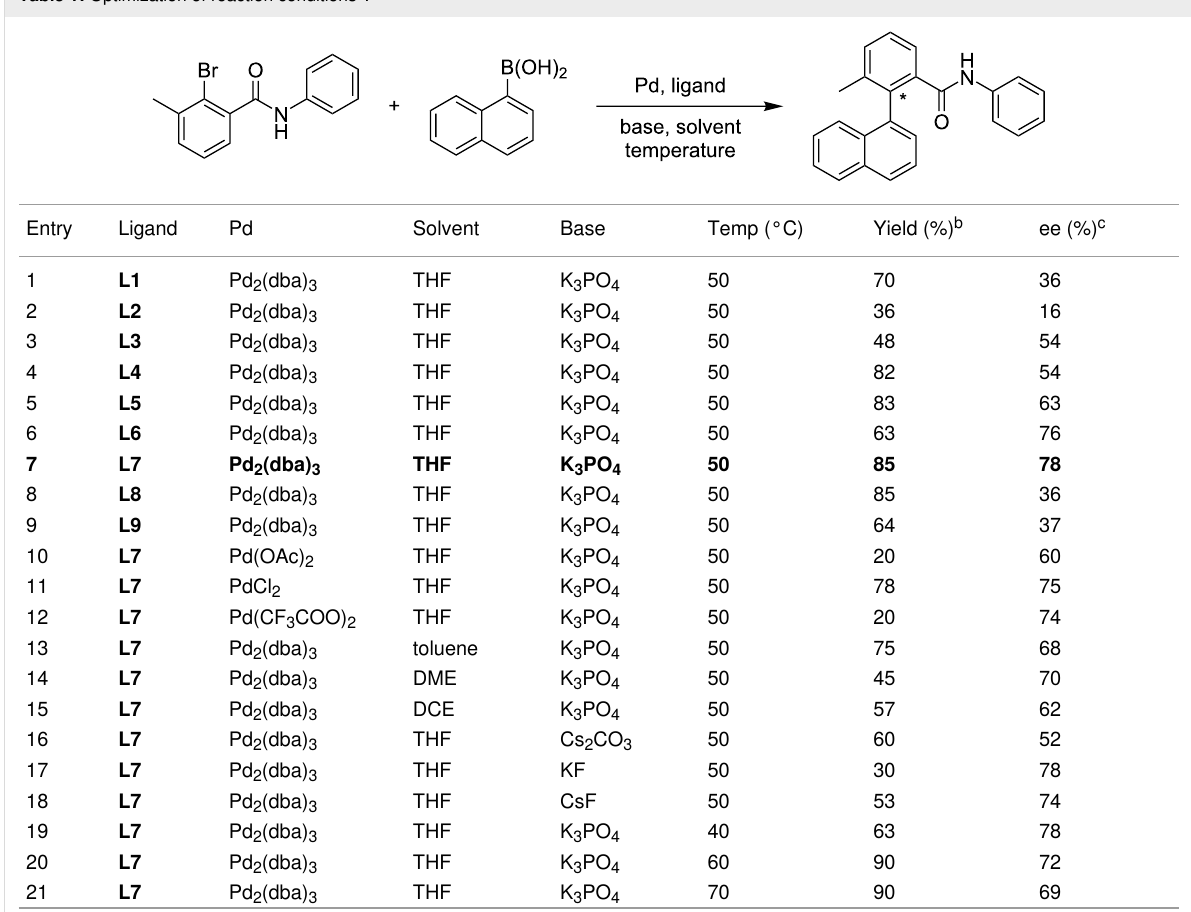
Table 1: Optimization of reaction conditions a